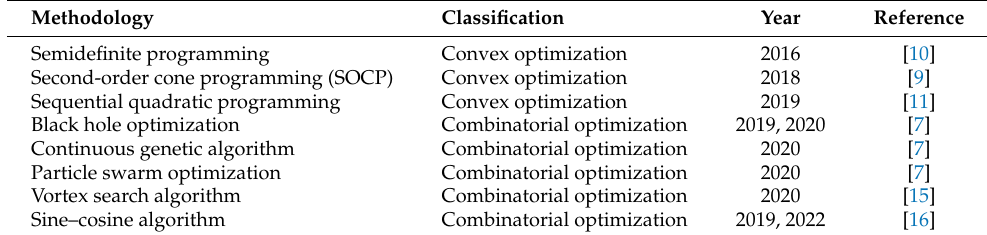
Table 1. Main literature reports applied to the OPF solution in monopolar DC